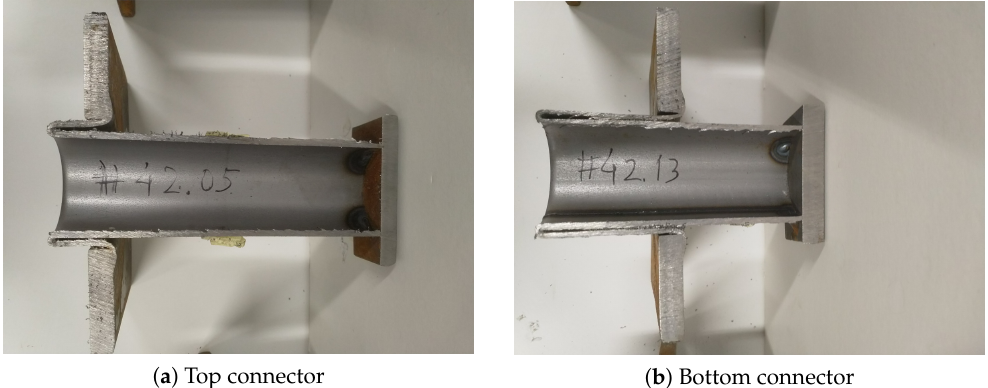
Figure 11. Sample panel 4B—Longitudinal section: final state of the inversion of φ 42 × 1.5 mm tubes.